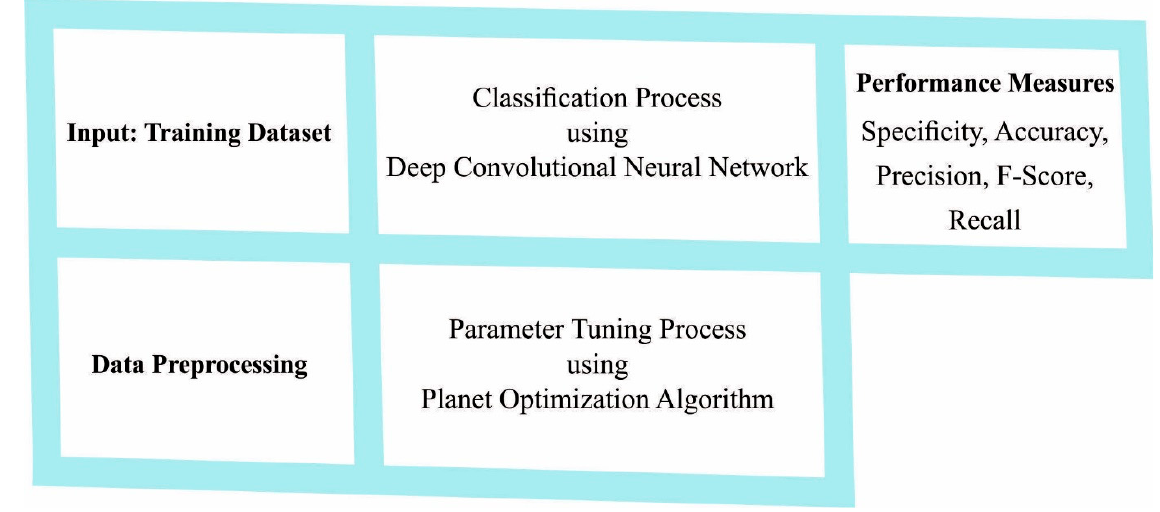
Figure 1. Overall process of PODCNN-LWID approach.